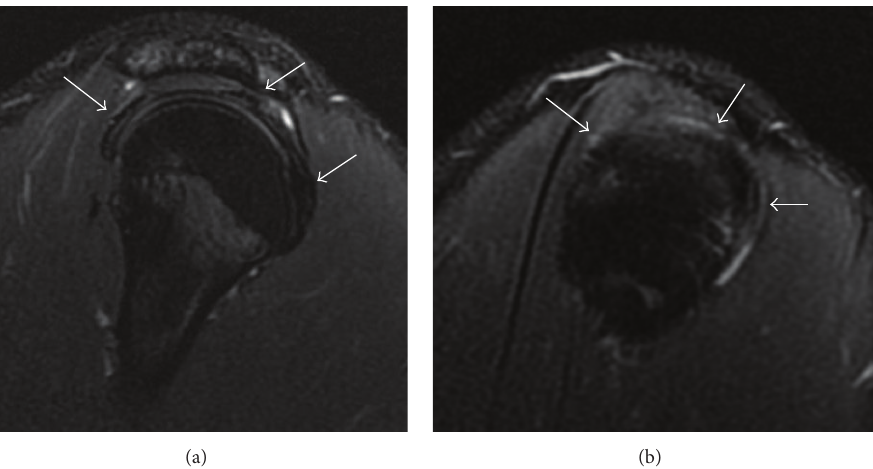
Figure 5: Sagittal T2 FS SE MR images of the right shoulder (TR = 2600; TE = 63.9; NEX = 3; EC = 1) (a) and (b) demonstrating the rotator cuff tendons (white arrows) with normal thickness and hypointensity, without tears.